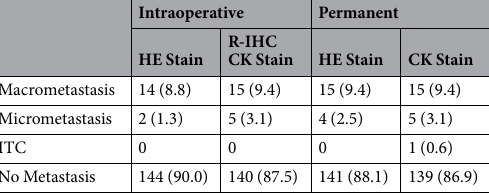
In this study, we detected more micrometastases than macrometastases using R-IHC, which is in contrast to conventional HE staining. However, many trials have concluded that the presence of micrometastases has no impact on patient outcome and no impact on whether or not to use systemic treatment or lymph node radio- therapy 8 . The ACOSOG Z 0011 12 and AMAROS trials 13 showed that axillary dissection could be safely omitted